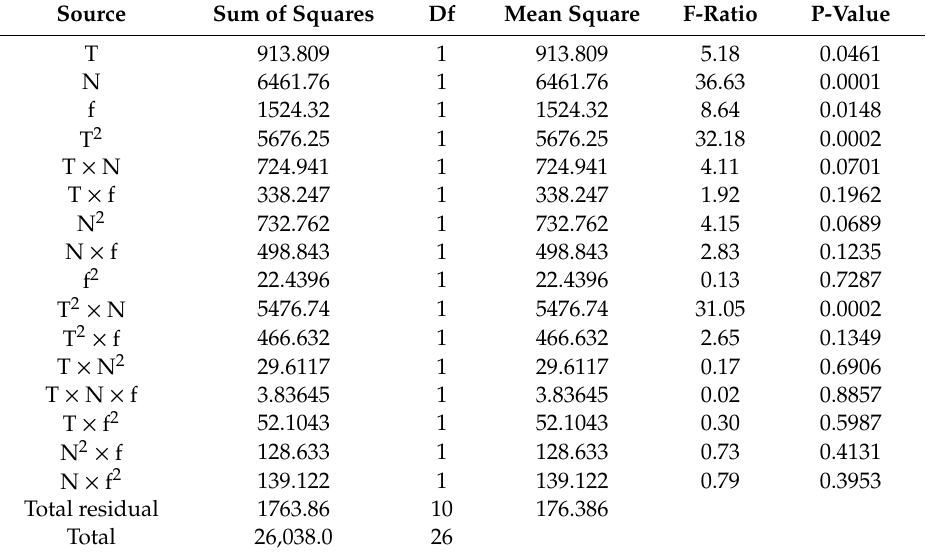
Table 3. Analysis of Variance for Ft .